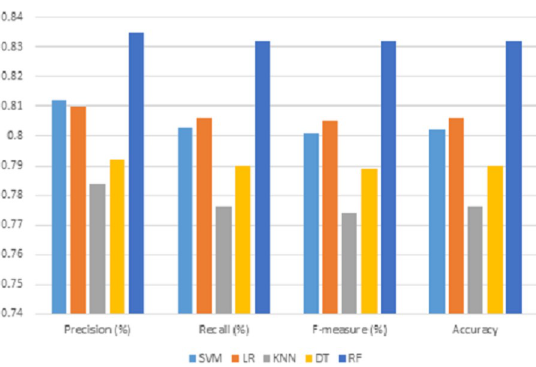
Fig 3. Performance results of different classification algorithms on the lexical feature only.